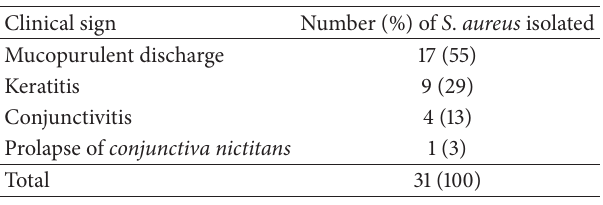
Table 3: Isolation rate of S . aureus from food producing animals with specific clinical